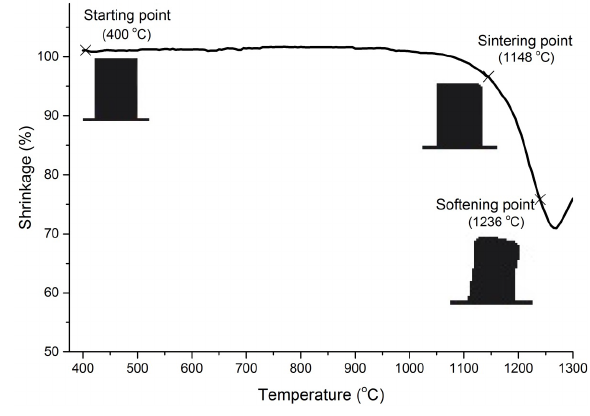
Figure 5. The behaviour of Sille stone during heating to the temperature of 1300 °C at the rate of 50 °C min -1 .